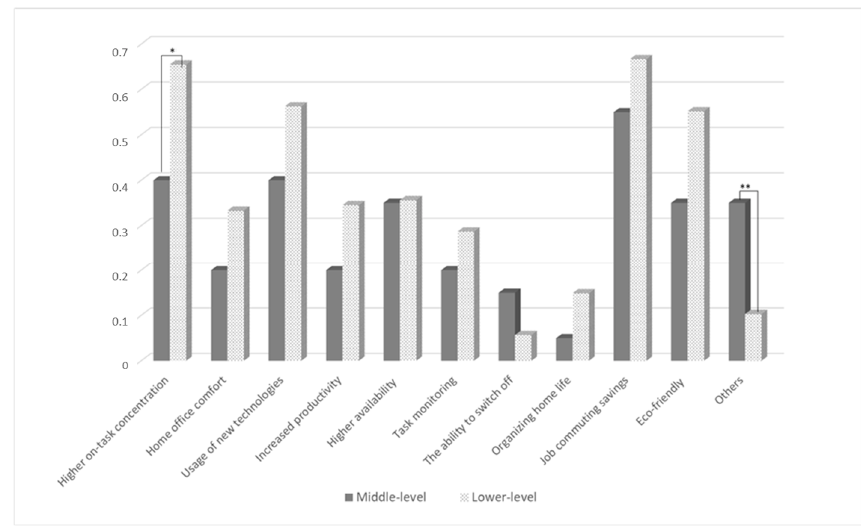
Figure 1. Remote work benefits perceived by lower- and middle-level managers. Notes. * p < 0.05; ** p < 0.01.